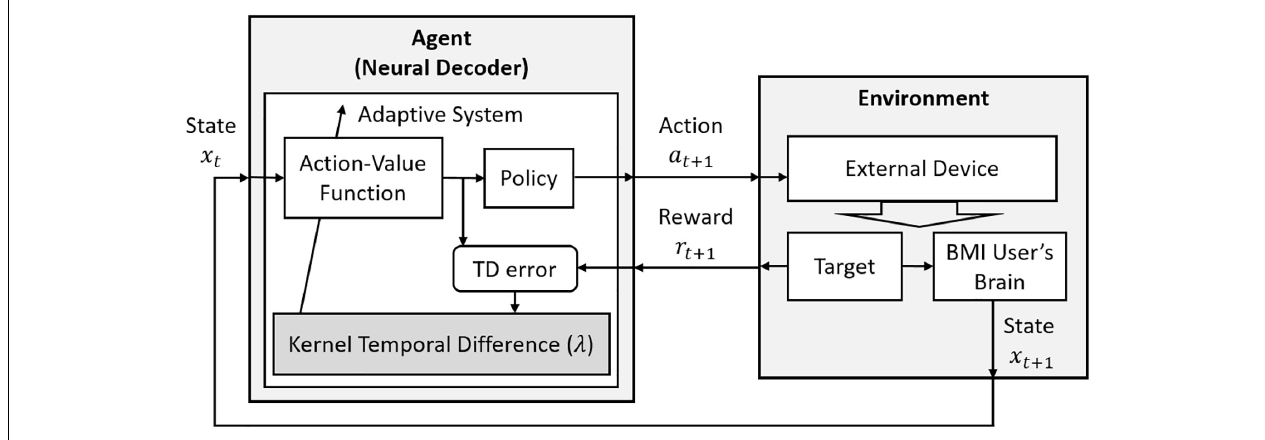
FIGURE 3 | The decoding structure of RLBMI using a Q -learning via Kernel Temporal Difference( λ ). This figure is modified based on Figure 1 in Bae et al.